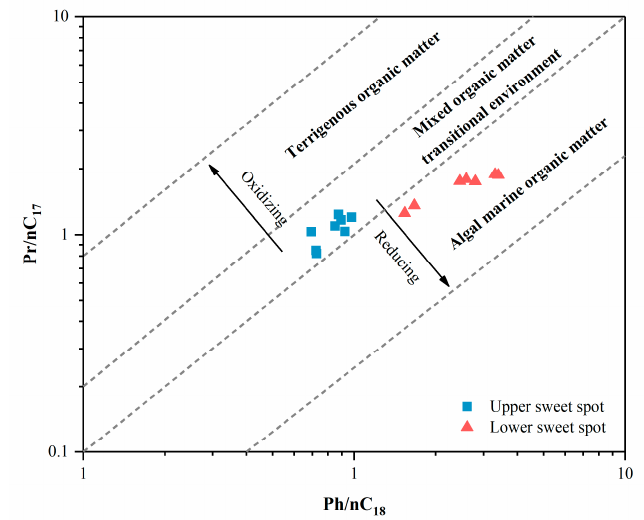
Figure 12. Plot of phytane to nC 18 alkane (Ph / nC 18 ) vs. pristane to nC 17 alkane (Pr / nC 17 ), showing depositional conditions and types of organic matter.